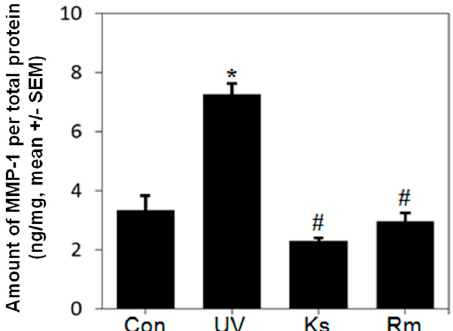
Figure 2. Kochia scoparia (Ks) and Rosa multiflora (Rm) inhibit UVB-induced MMP-1 expression. Normal human fibroblast (NHF) cells were treated with the methylene chloride (MC) fraction of Ks or Rm (10 µg/mL for each) for 1 h, exposed to UVB irradiation (20 mJ/cm 2 ) and treated with 10 µg/mL of the MC fraction of Ks or Rm for 48 h to measure MMP-1 expression. Relative MMP-1 protein expression in Ks- or Rm-treated NHF cells was determined by ELISA. Ks and Rm significantly inhibited MMP-1 secretion in UVB-irradiated NHF cells. Con: sham light control, UV: UVB irradiation, Ks: Kochia scoparia treatment, Rm: Rosa multiflora treatment. Each bar represents the mean ± SEM of duplicates. * p < 0.05 vs control; # p < 0.05 vs UV.